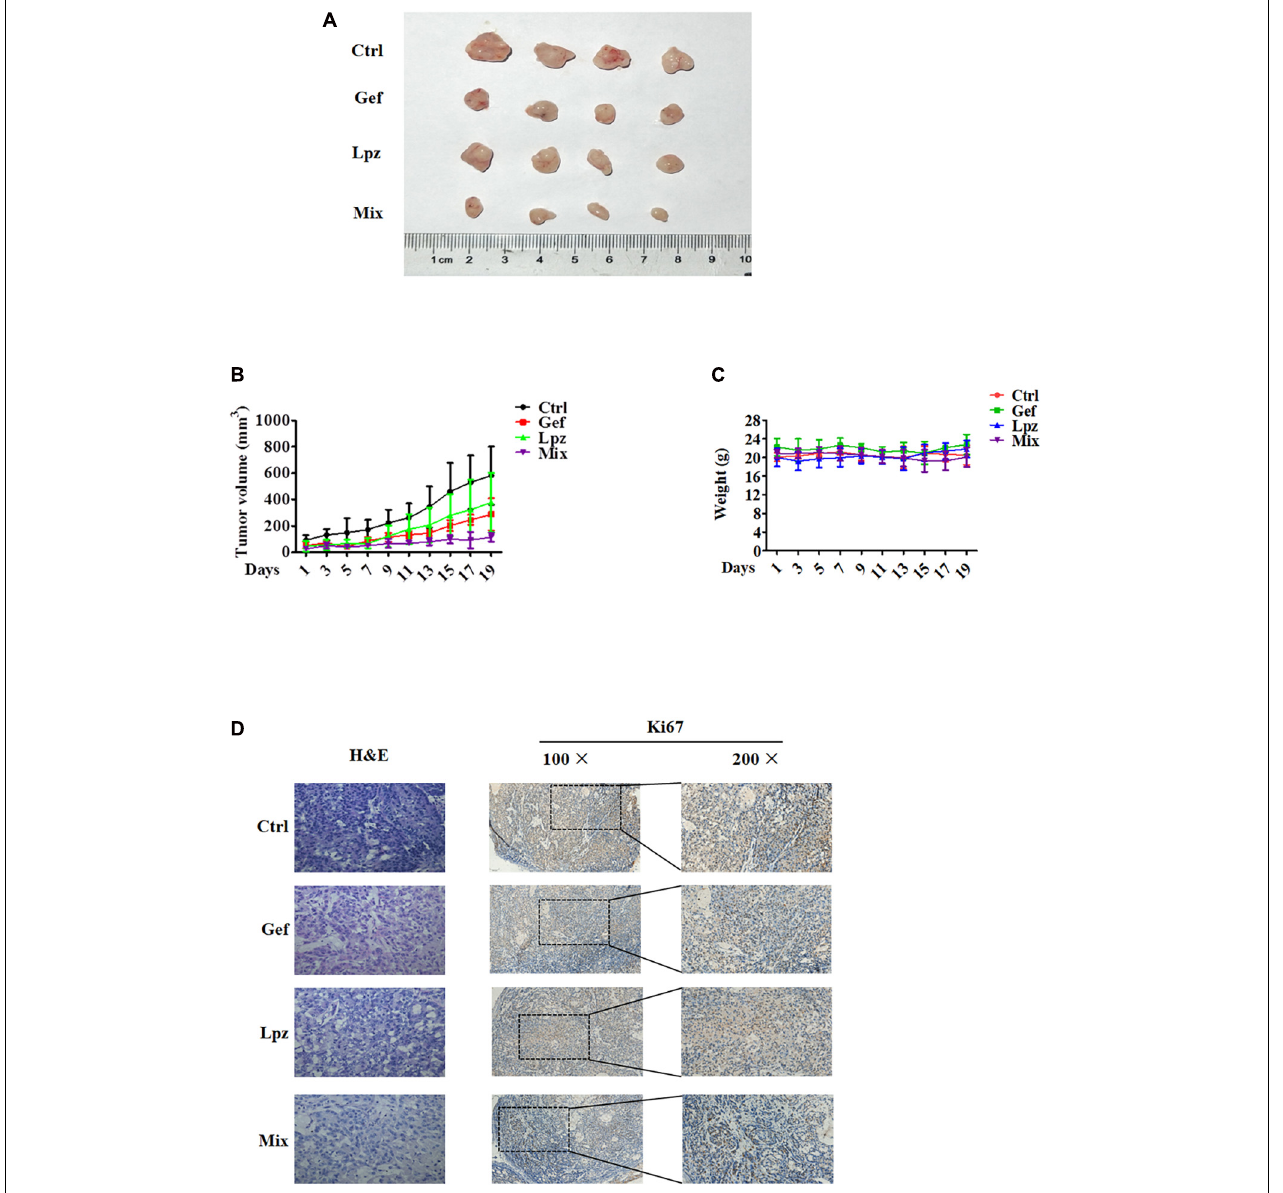
FIGURE 6 | Lansoprazole in combination with Gef reduces the growth of A549 subcutaneous xenografts. Equal amounts of A549 cells were injected subcutaneously into nude mice. Once the tumor volume grew to 30–50 mm 3 , mice were randomized into four groups and treated with Lpz (25 mg/kg) or Gef (80 mg/kg) either alone or in combination (Lpz was administered orally 2 h before Gef) every other day for 19 days. (A) Representative images of the tumors removed from nude mice. (B) Quantification of tumor volume. (C) No significant differences in weight were found between the Lpz-, Gef-, or combination-treated groups. (D) Immunohistochemical staining of Ki67 in tumor tissues of different